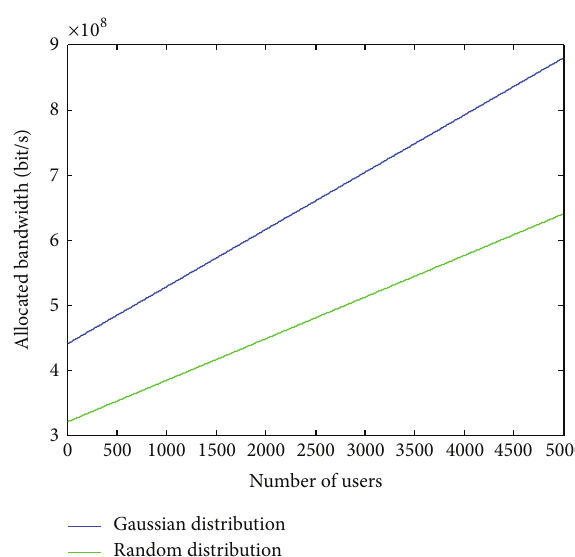
Figure 2: Simulation of allocating required bandwidth.